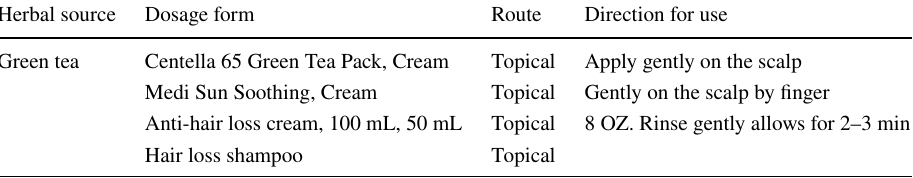
Table 7 Market formulation for green